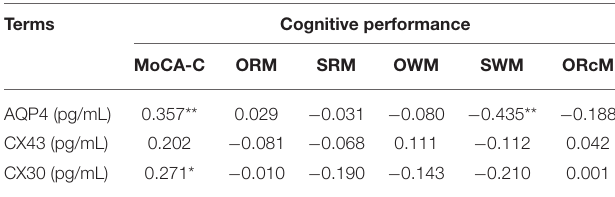
TABLE 5 | Partial correlation analysis between AQP4/CX43/CX30 and cognitive